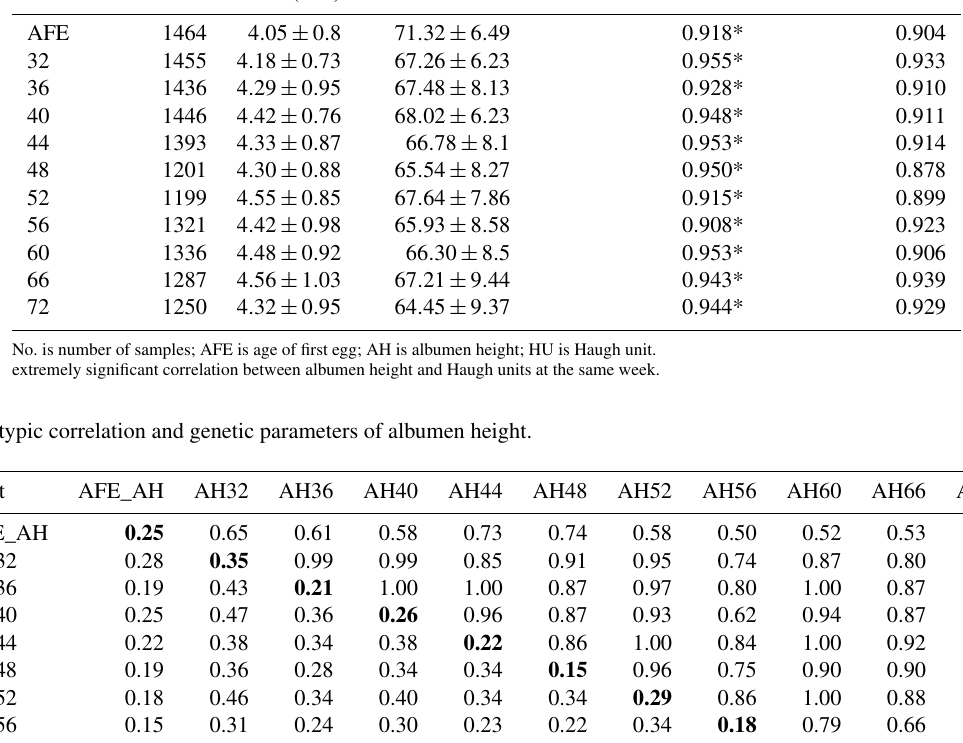
Genetic correlations (upper triangle) and phenotypic correlations (above diagonal) and with heritability estimates in the diagonal. AFE_AH = first egg albumen height; AH32, AH36, AH40, AH44, AH48, AH52, AH56, AH60, AH66, AH72 = albumen height every 4 weeks from 32 to 60 weeks old, and every 6 weeks from 60 to 72 weeks